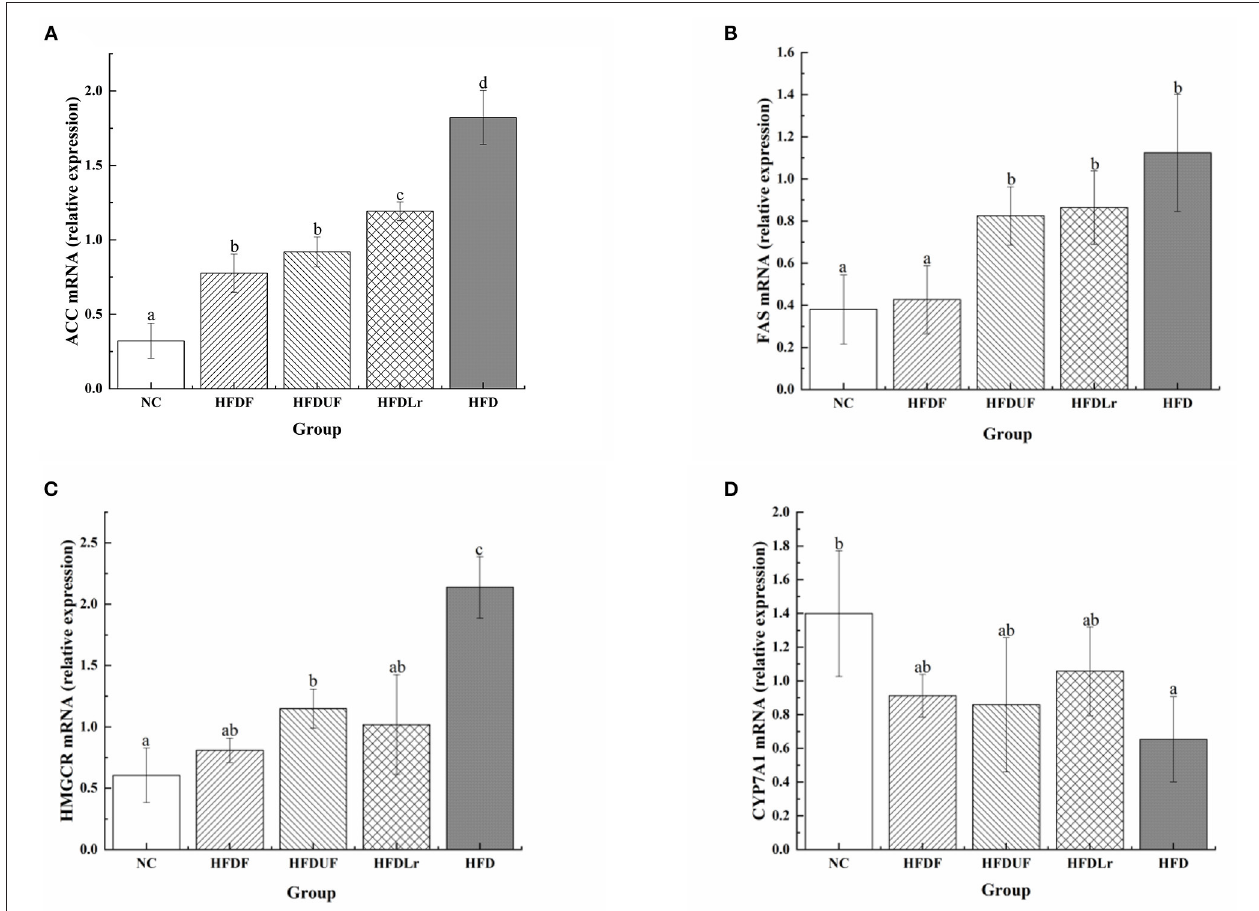
FIGURE 5 | The effects of CSM on the mRNA expression of lipid metabolism-related genes in mice livers. (A) acetyl-CoA carboxylase (ACC), (B) fatty acid synthase (FAS), (C) HMG-CoA reductase (HMGCR), (D) cholesterol 7 alpha-hydroxylase (CYP7A1). The mRNA levels were determined using real-time quantitative PCR (qPCR) and normalized to the mRNA expression levels of β -actin. All data are expressed as the mean ± SD ( n = 10 mice/ group). The statistical differences between groups were analyzed using ANOVA. A p -value < 0.05 was considered statistically significant. The superscript letters indicate significant differences between